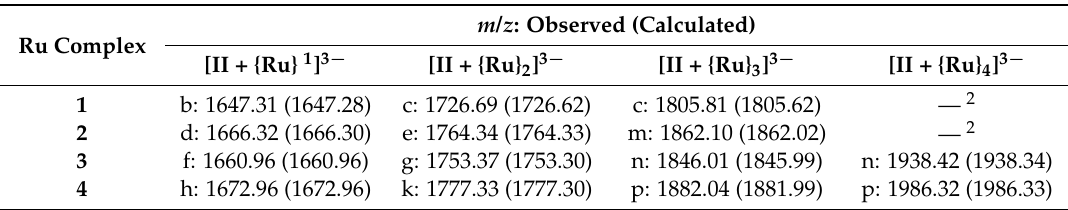
Table 3. Negative ions observed by ESI-MS for the HPLC fractions shown in Figure 4 (for mass spectra, see Figure S8 in supplementary materials).